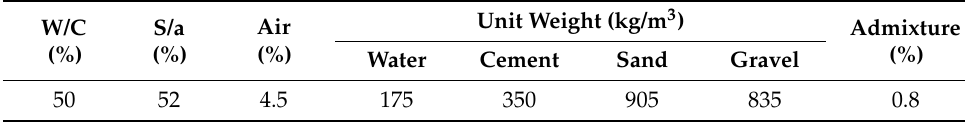
Figure 2. Particle size distribution of ( a ) fine and ( b ) coarse aggregates.